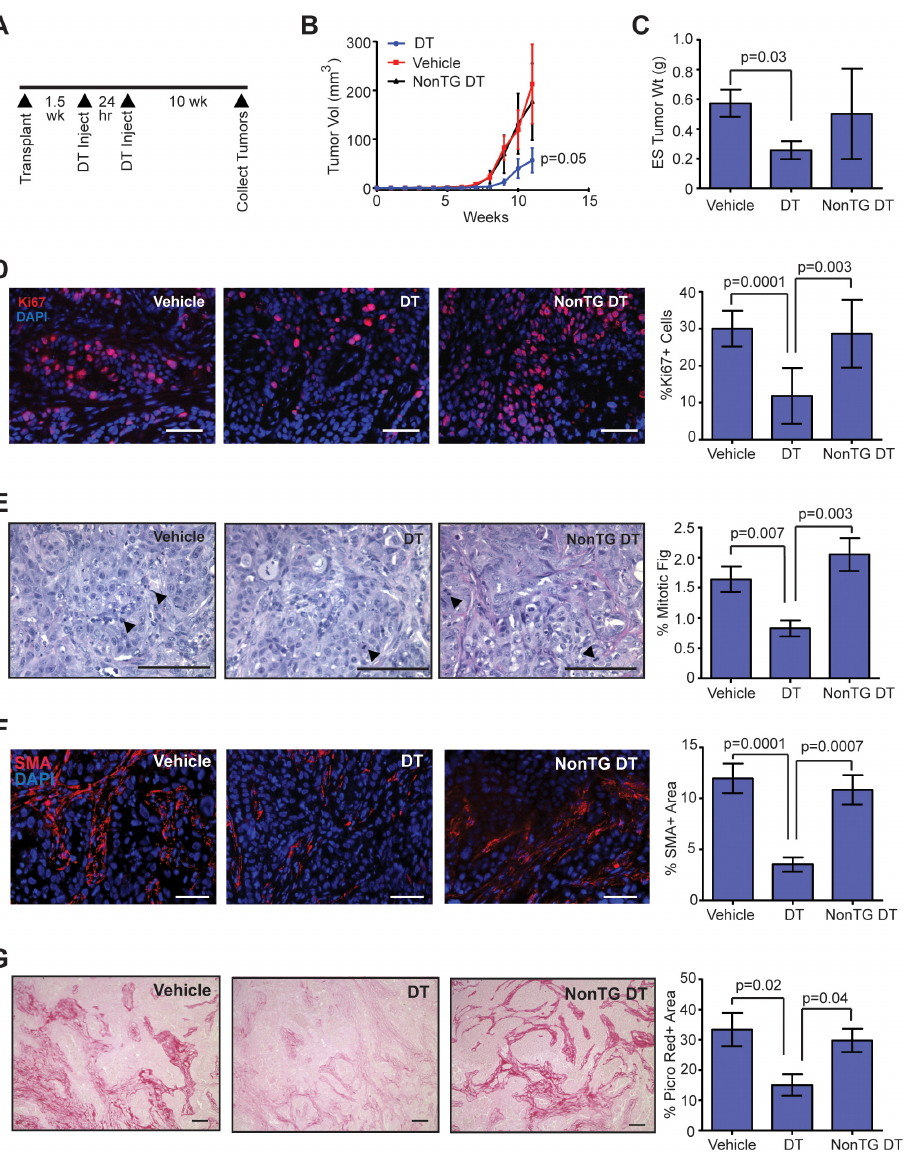
Figure 3. Depletion of CD11b + cells early in tumor development reduces tumor growth, collagen-producing cells, and collagen deposition within tumors. ( A ) DTR-CD11b (Mac/SCID) transgenic mice and non-transgenic littermates (NonTG) were humanized with stromal vascular fraction (SVF)/CCL2 cells, then transplanted with oncogenic human breast epithelial cells. Mice were injected with two doses of vehicle or diphtheria toxin (DT) at 1.5 weeks post-transplantation to reduce CD11b + cells. ( B ) Tumor growth curves following epithelial cell transplantation and treatment with vehicle or DT ( n = 8 tumors/group; two-way ANOVA analysis with Tukey’s multiple comparisons test). ( C ) Tumor weight measured at end-stage ( n = 8 tumors/group). ( D ) Percent of cells expressing proliferation marker Ki67 in end-stage tumors ( n = 8 tumors/group). ( E ) Percent of mitotic figures in end-stage tumors ( n = 8 tumors/group). ( F ) Percent area of SMA + cells in end-stage tumors ( n = 8 tumors/group). ( G ) Percent area of picrosirius red stained collagen in end-stage tumors ( n = 8 tumors/group). Statistical differences detected using one-way ANOVA analysis with Tukey’s multiple comparisons test. Magnification bars = 50 µm.